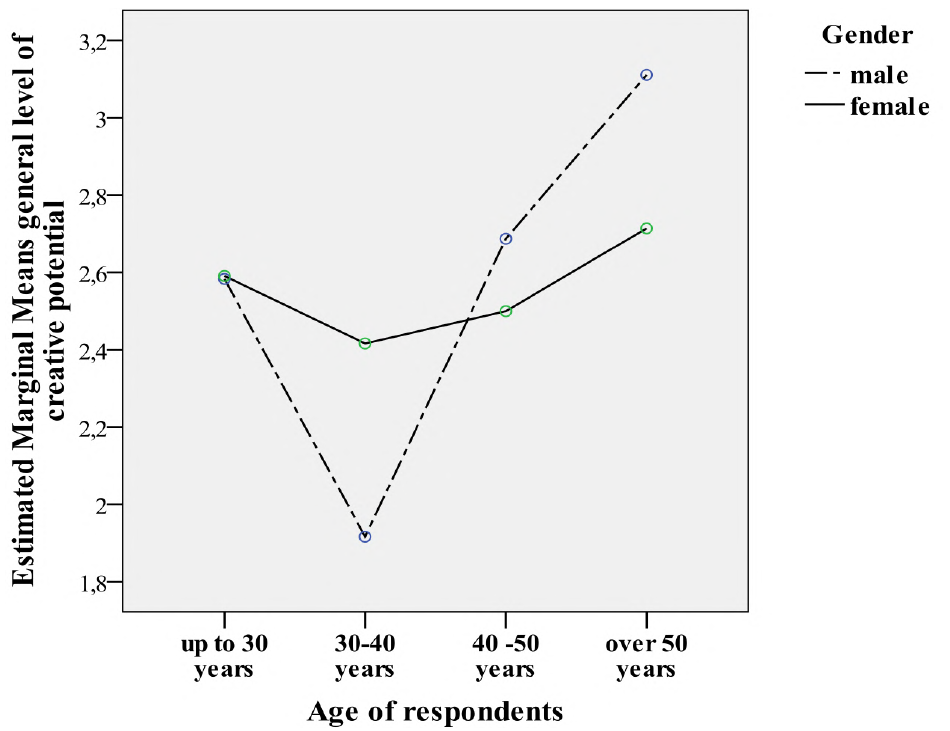
Figure 82: Presentation of paper